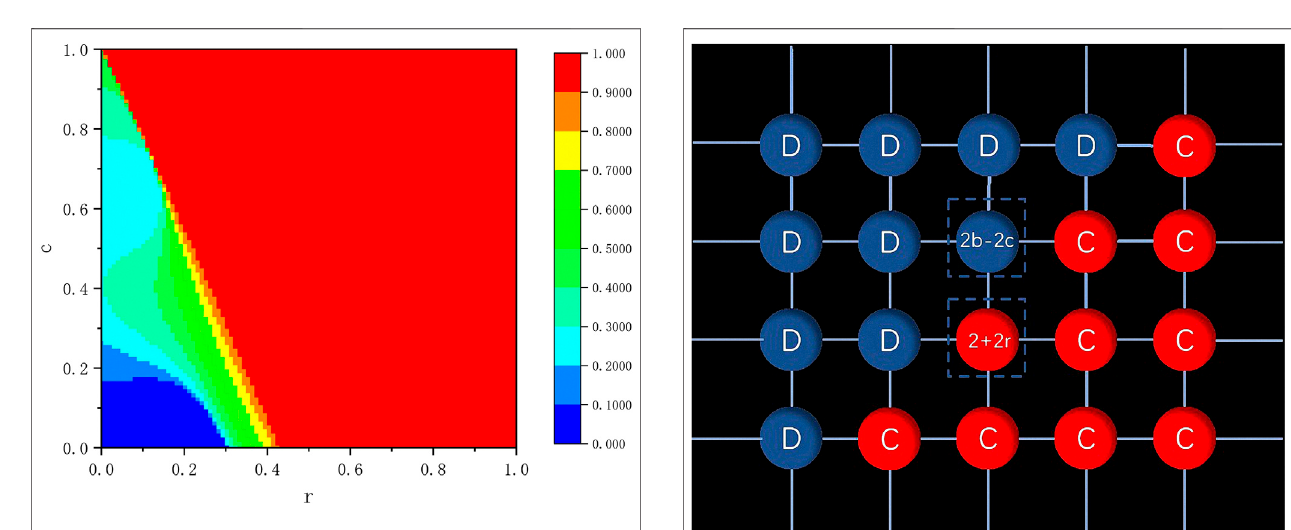
FIGURE 2 | Fraction of cooperation on the r-c parameter space when b (cid:1) 1.3.